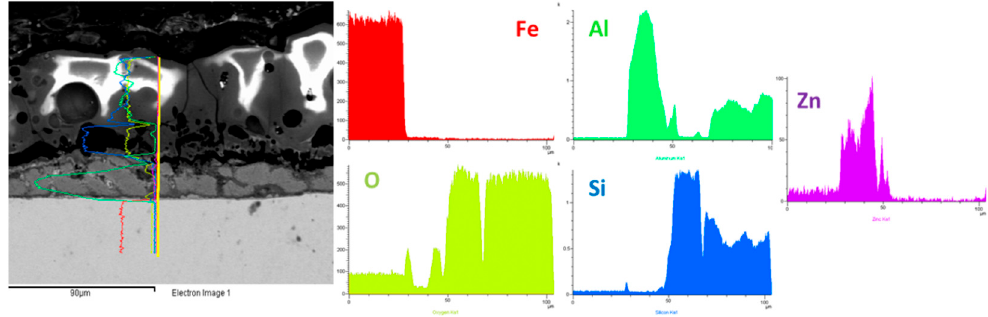
Figure 6. EDS elemental line analysis of the sample obtained working at 1 A/cm 2 in UPC with small particles.